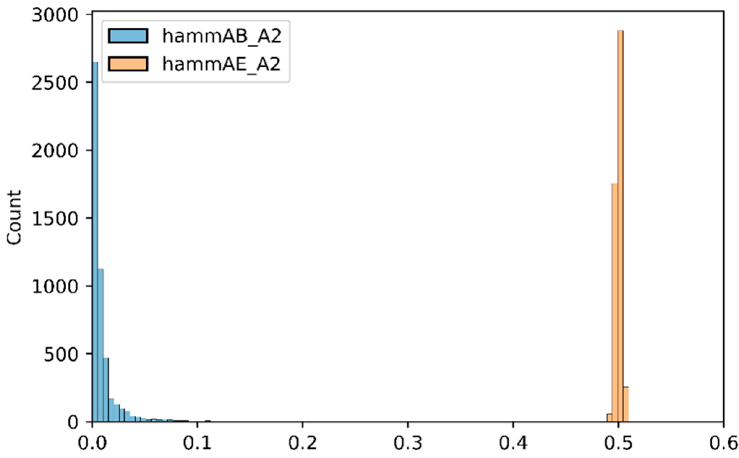
Figure 10. Histogram of normalized Hamming distances between Alice and Bob (0.0096 ± 0.0169), and Alice and Eve (0.5000 ± 0.0026), after the second iteration of the BPAD algorithm.